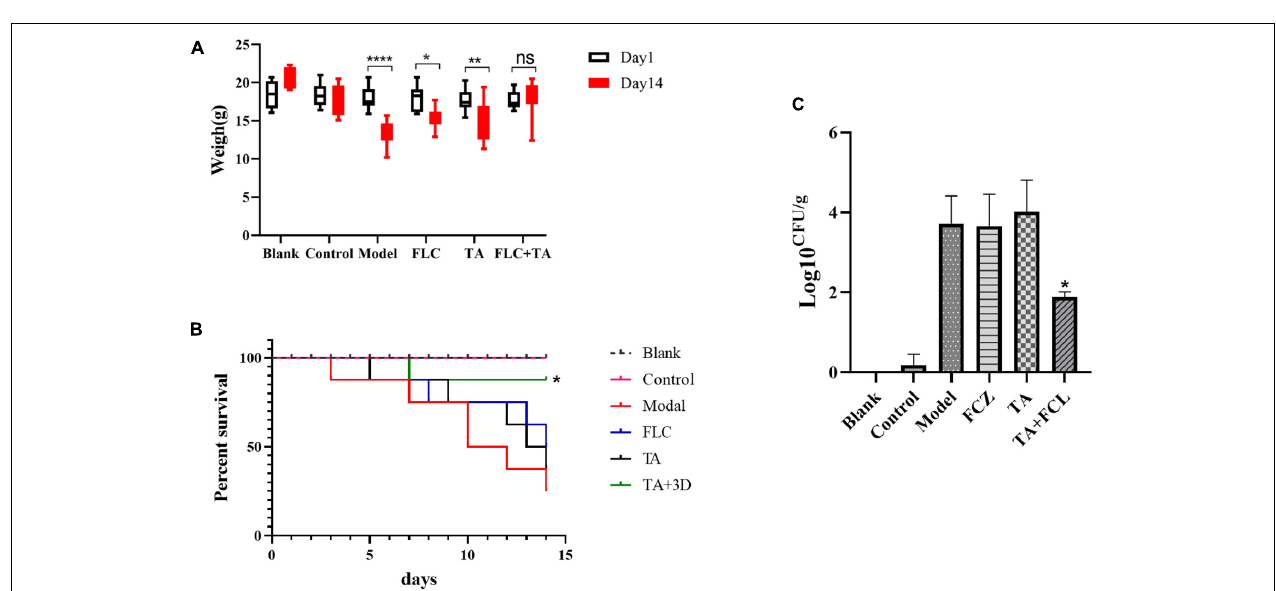
FIGURE 3 | The effect of TA combined with FLC on C. albicans biofilm. The morphology of biofilm and hyphae were observed using a microscope (magnification 400 × ) after incubation at 37 ◦ C for 24 h and staining with 0.4% crystal violet. FLC combined with TA effectively inhibited C. albicans biofilm formation and positively affected the pre-formed C. albicans biofilm.